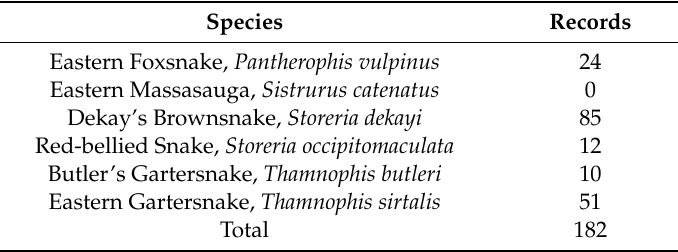
Table 2. Road mortality records used in a snake road mortality hotspot analysis. Records were compiled from systematic and incidental occurrences and are limited to seven major arterial and collector roads in the study area surrounding the Ojibway Prairie Complex in Windsor and LaSalle, Ontario [46]. Common and scientific names follow Crother et al.